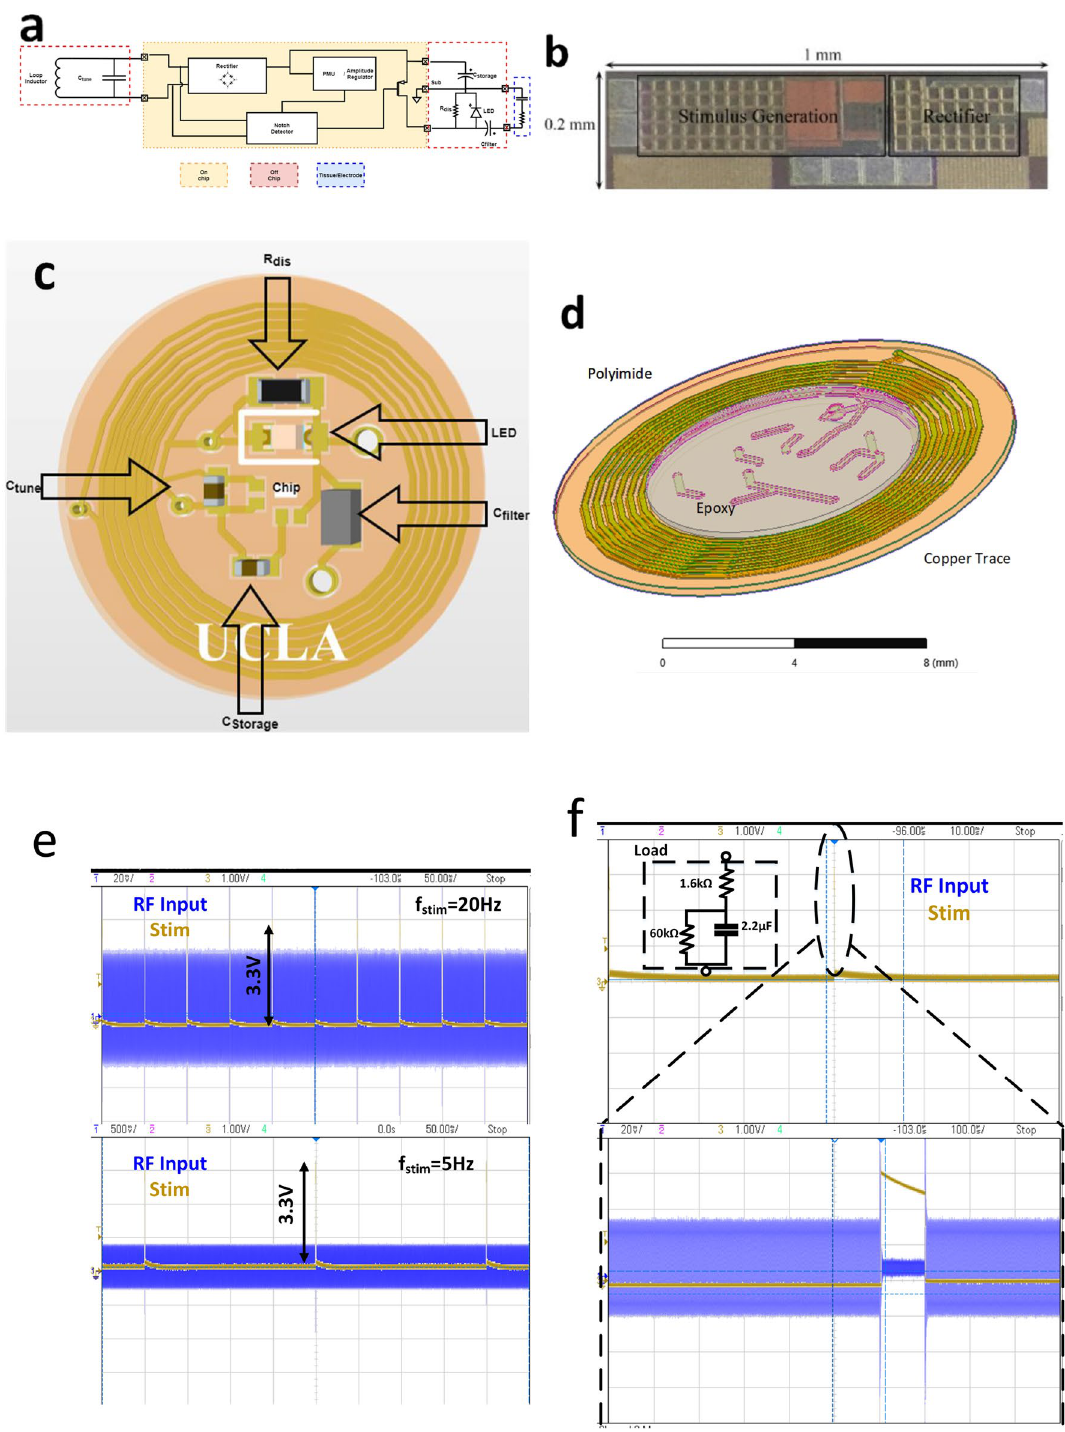
Figure 2. Stimulator design. ( a ) Block diagram of the designed chip. ( b ) Picture of fabricated IC. ( c ) Assembled components on the top side of stimulator PCB. ( d ) 3D model of Rx coil. ( e ) The Measured response of the stimulator to 5 Hz and 20 Hz stimulation. ( f ) The measured response of stimulator to 100 µ s stimulation across the modeled